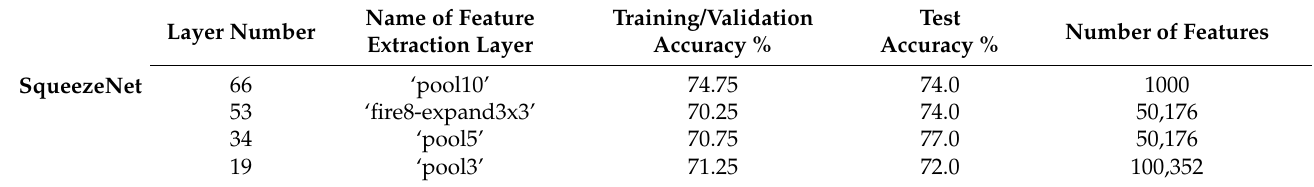
Table 8. Classification performance of SVM using the autonomous features from SqueezeNet.